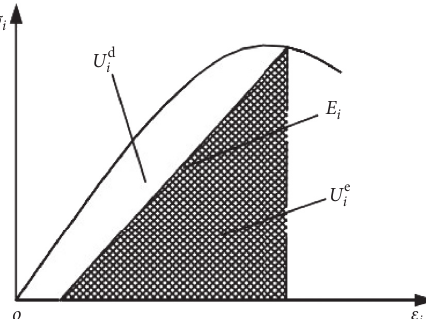
Figure 8: Quantitative relationship of energy release and energy